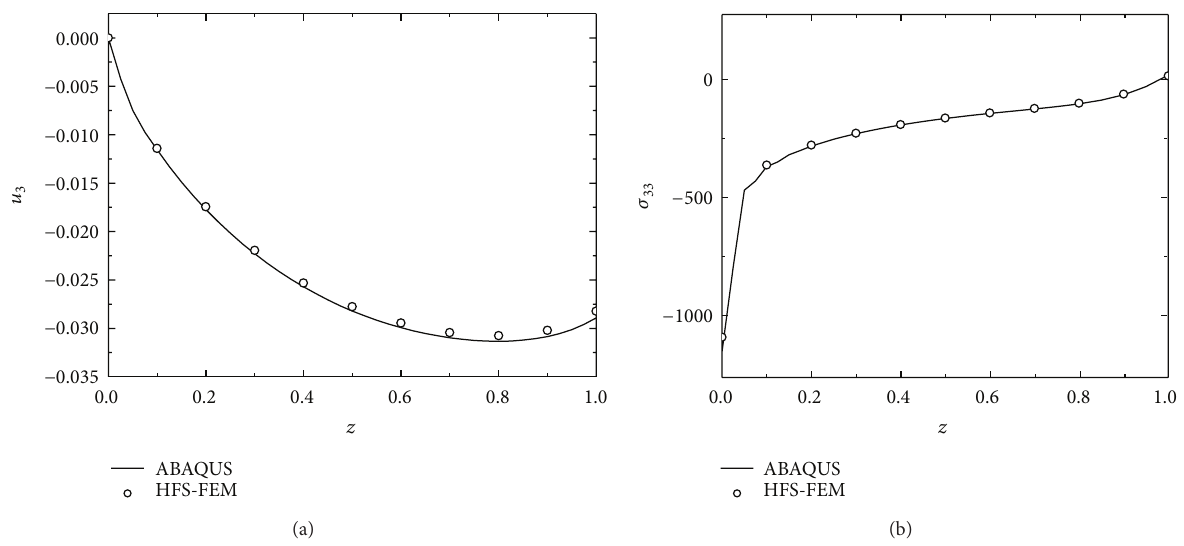
Figure 16: (a) Displacement 𝑢 3 and (b) stress 𝜎 33 along one cube edge when subjected to arbitrary temperature and body force.